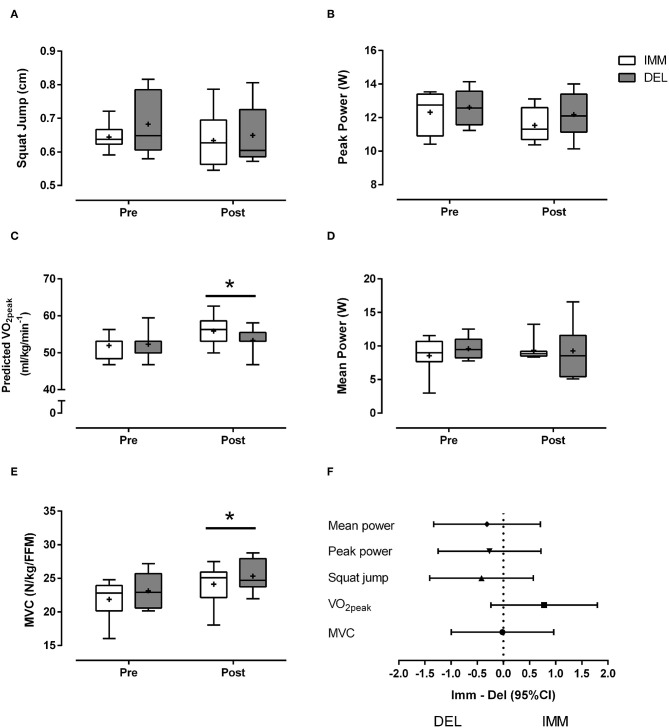
Box and whisker plot of (A) squat jump, (B) peak power (C) predicted VO2peak
(D) mean anaerobic power, and (E) MVC normalized to fat-free mass (FFM) before (Pre) and after (Post) 5 days of evening variable intensity exercise with protein consumption immediately after exercise (IMM) or the following morning (DEL). “Post” refers to testing that occurred 2 days after the final exercise bout. The horizontal line within the box represent the median, the boundaries around the box represent the 25 and 75th percentile, the whiskers indicate the minimum and maximum values, and the “+” marked in the box represent the mean. *different from pre (P < 0.05). Mean ± SD. (F) Effect sizes (Cohen's d: small = 0.2–0.5; moderate = 0.5–0.8; large = >0.8) and 95% confidence intervals for the mean effect of IMM– DEL on performance outcomes.